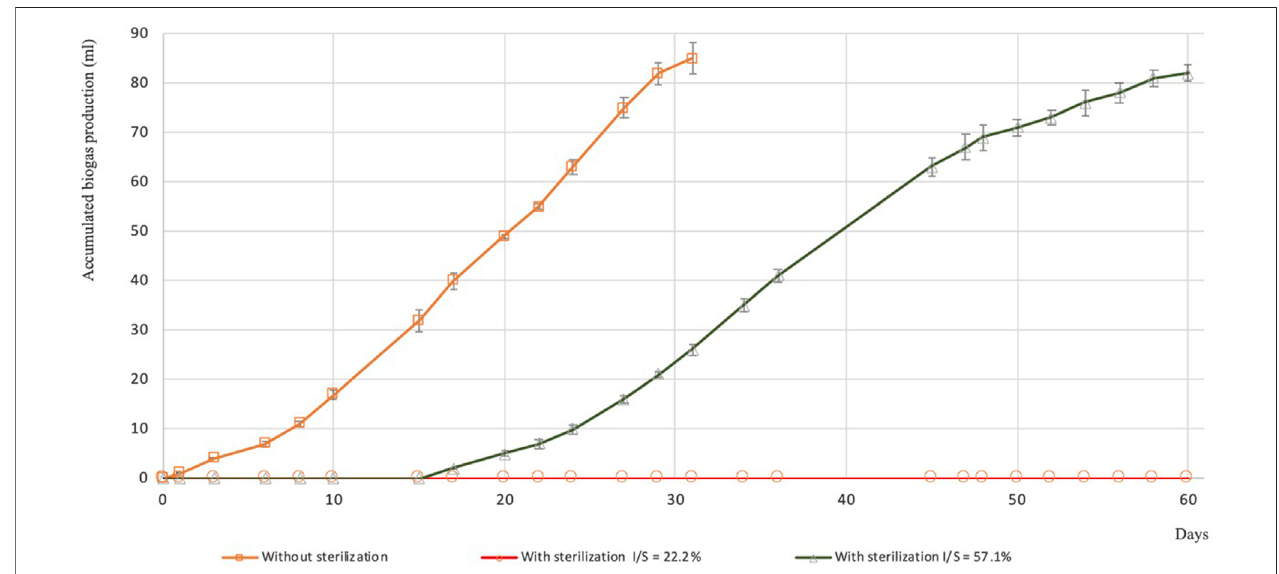
FIGURE 5 | Effect of sterilization/thermal pre-treatment on biogas production.